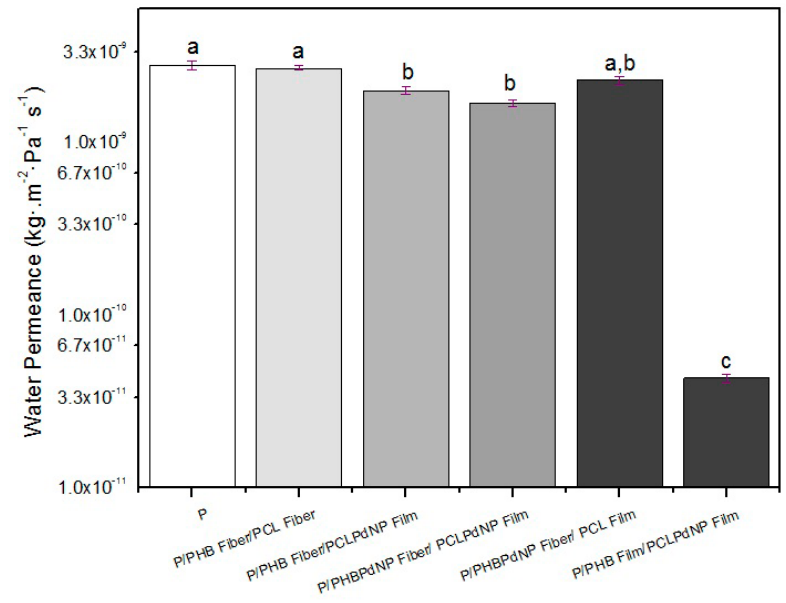
Figure 12. Water vapor permeance (WVP) of paper and Paper/PHB/PCL multilayers with and without palladium nanoparticles (PdNPs). Different letters indicate significant differences among samples (p < 0.05).